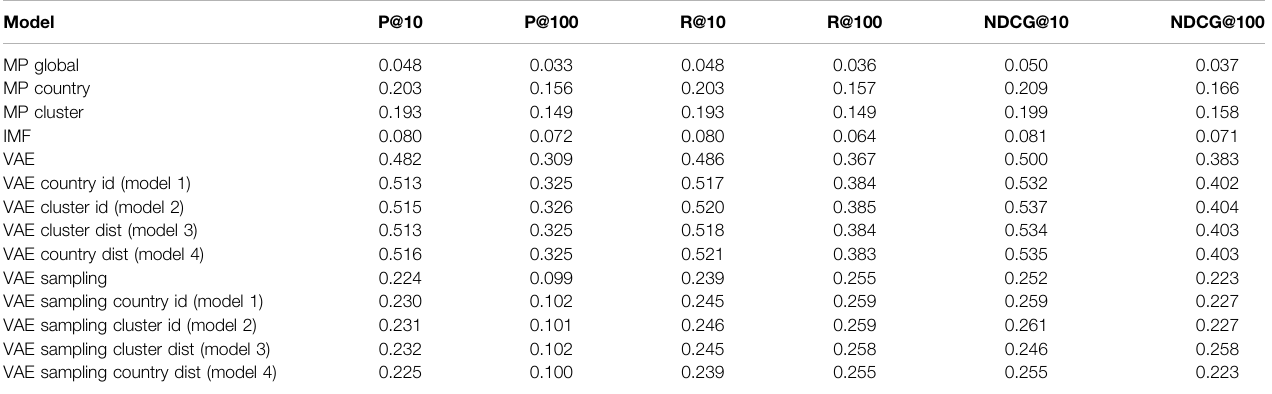
TABLE 3 | Results with respect to Precision@K, Recall@K, and NDCG@K metrics.